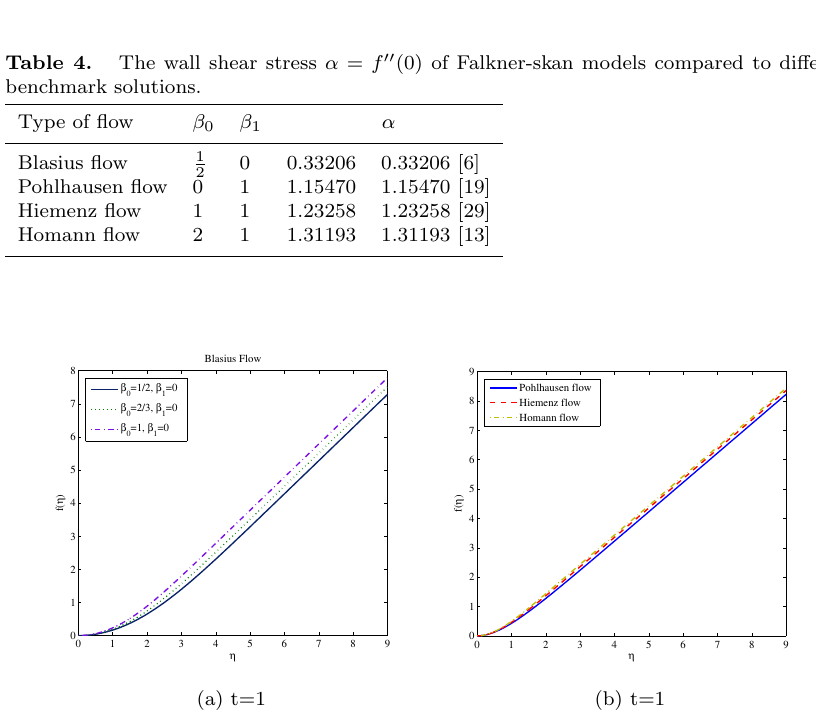
Figure 1. The Solution of Falkner-Skan problem for the cases of: Blasius problem β 1 = 0 (left) and Pohlhausen, Hiemenz, and Homann flows β 0 = 0 , 1 , 2 , respectively, with β 1 = 1 (right).